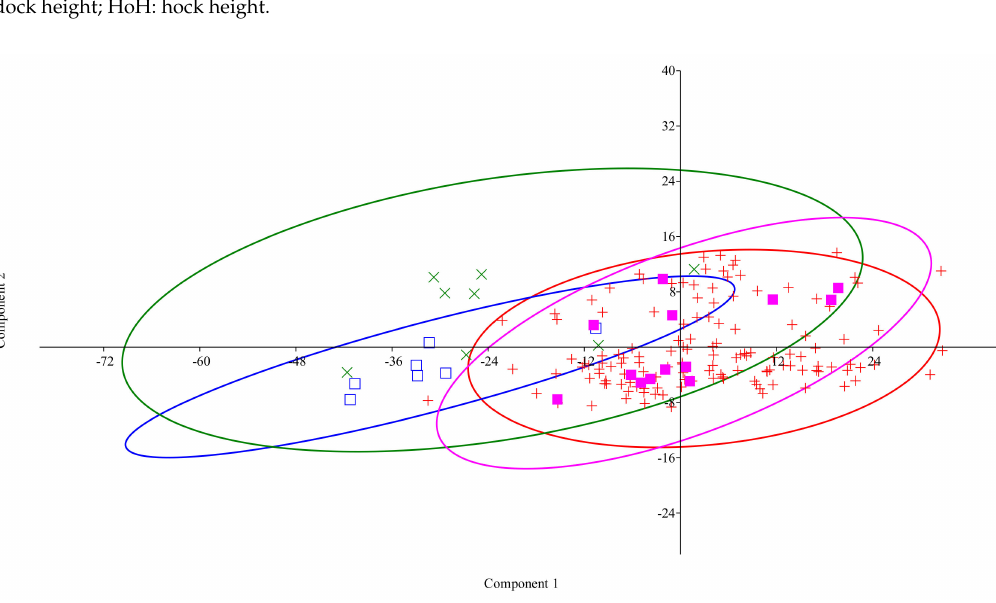
Figure 1. Principal component analysis plot run on the measured set of biometrical variables, with samples (individuals) separated by sex and species for adult 15 mules (7 males (cid:3) and 8 females x ) and 150 adult horses (137 uncastrated males + and 13 females (cid:4) ): First Principal Component (PC1) explained 93.9% of the total observed variance, and PC2 explained 3.8%. The placement of individuals in the ordination space showed no clear separation between